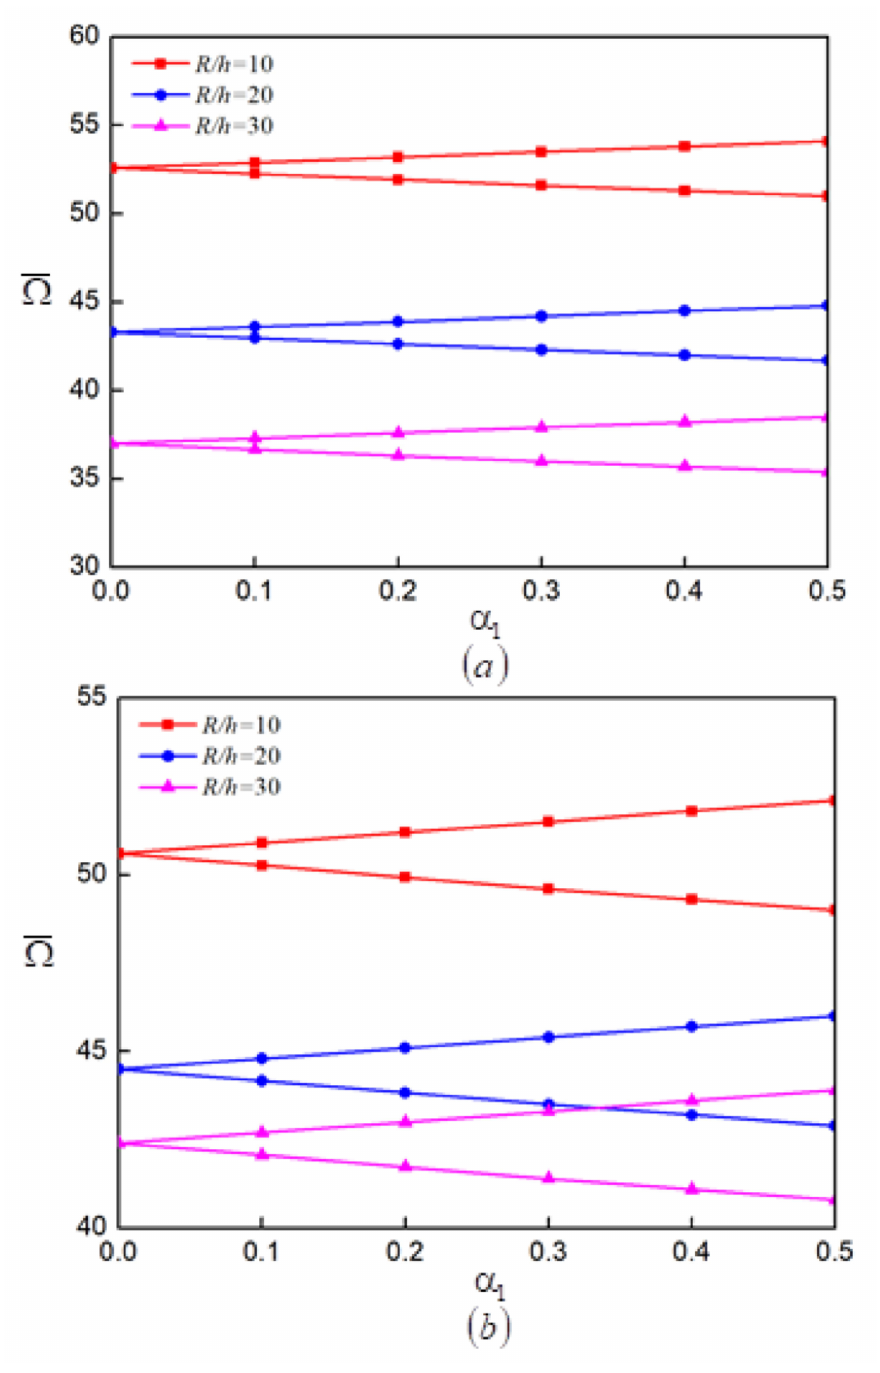
Figure 16. The dynamic unstable regions of the CFRP laminated cylindrical shell with different R / h : ( a ) the first mode, and ( b ) the second